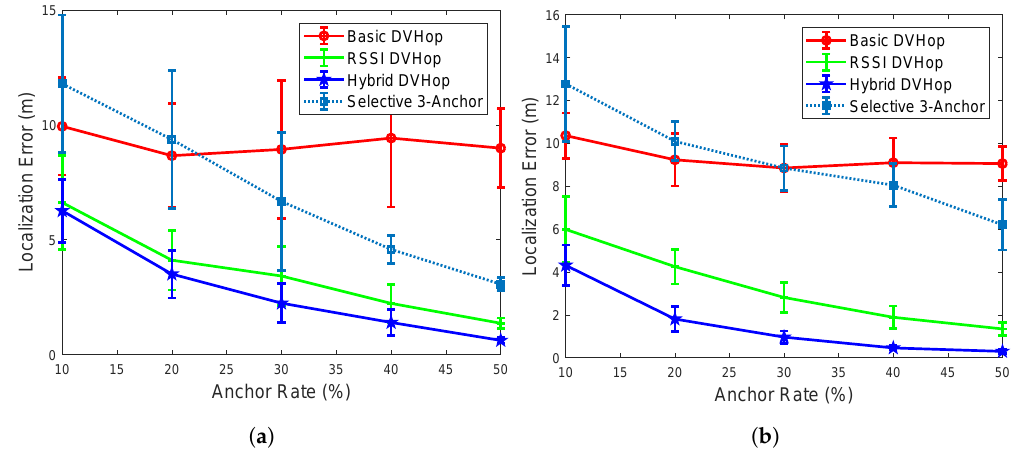
Figure 2. Localization error vs anchor rate. ( a ) Transmission range = 20 m; ( b ) Transmission range = 30